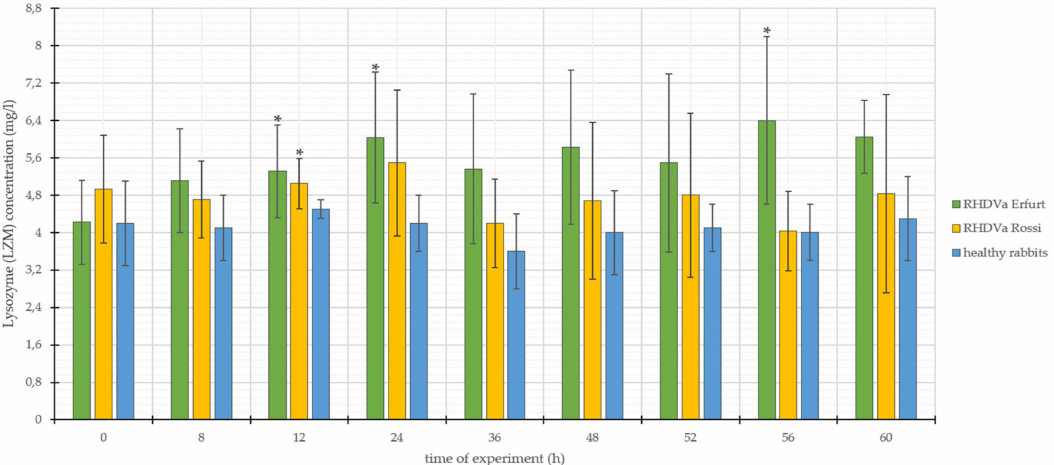
Figure 3. Values of lysozyme (LZM) concentration in rabbits infected with L. europaeus / GI.1a / Erfurt and L. europaeus / GI.1a / Rossi, as well as control rabbits. * statistically significant change respect to the control group ( p <